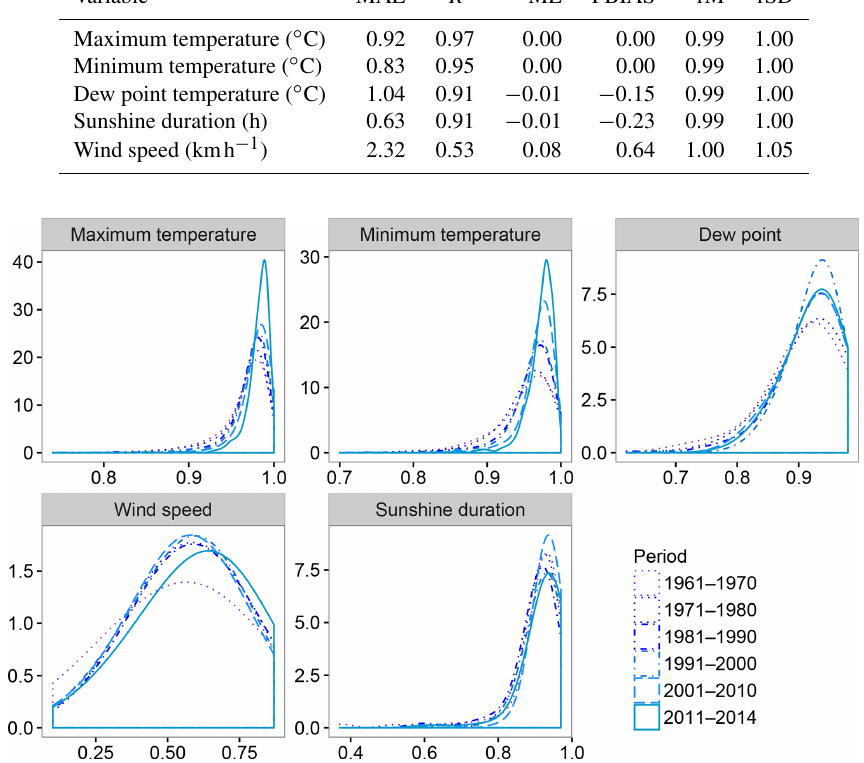
Figure 4. Kernel density of the gap filling R 2 , grouped by decadal periods.